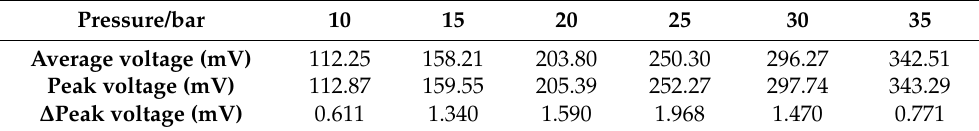
Figure 9. Diagram of sensor output during the rapid shock; the left picture is the separate output of the six sampling points, and the right picture shows a comparison of the six-point output. All pressure shocks were 0.4 bar. Table 4. Sensor spike shock data.